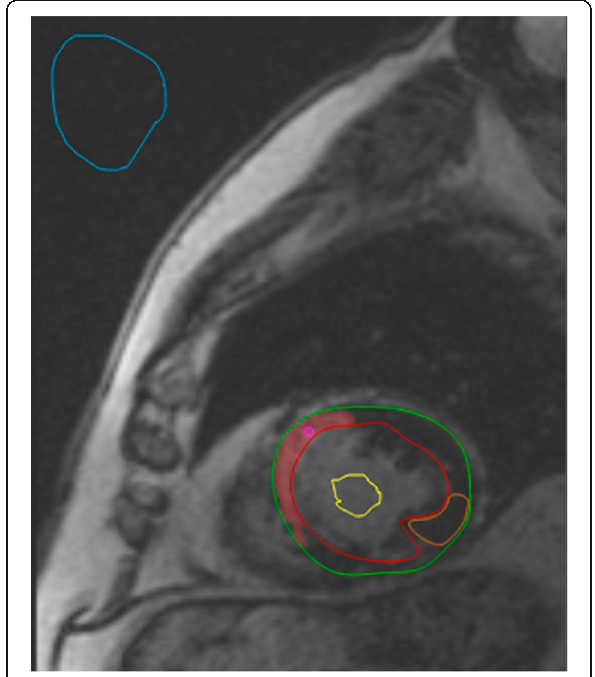
Fig. 1 Figure showing segmentation of the scarred myocardium in a 49-year-old male patient. Scarred myocardium is shown in red and is automatically segmented at 6 standard deviations above average signal intensity. Regions of interest placement is also depicted: those in the scarred (pink) and healthy (orange) myocardium are automatically placed during scar segmentation, while the ones in the blood pool (yellow) and air (blue) are manually placed on the same